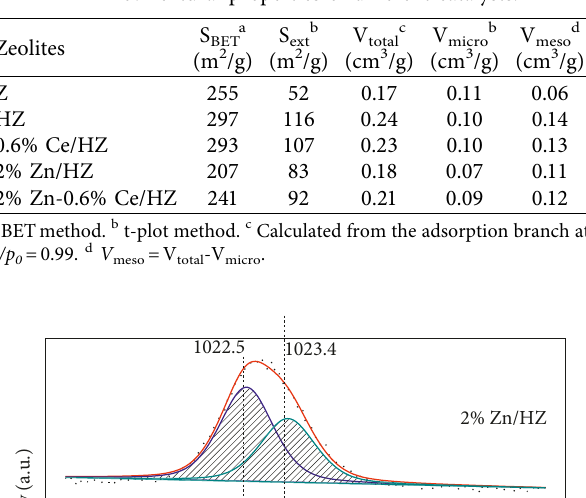
Table 3: Textural properties of different catalysts.